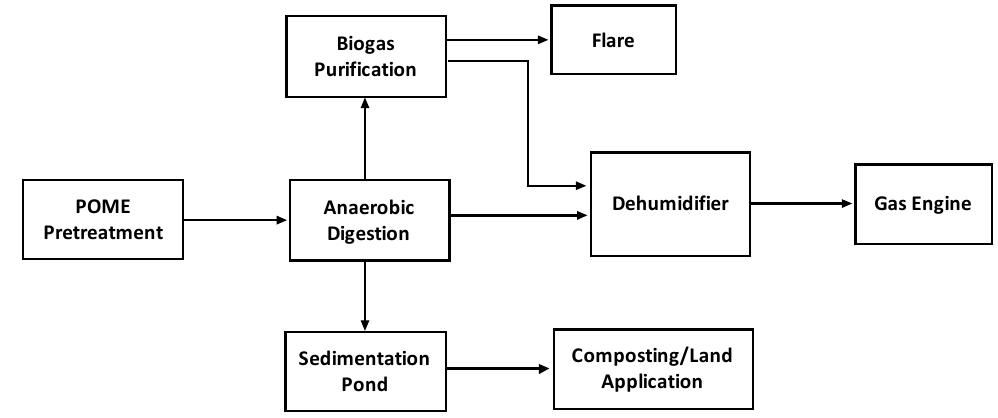
Figure 2. Process block diagram of biogas electricity generation from POME.